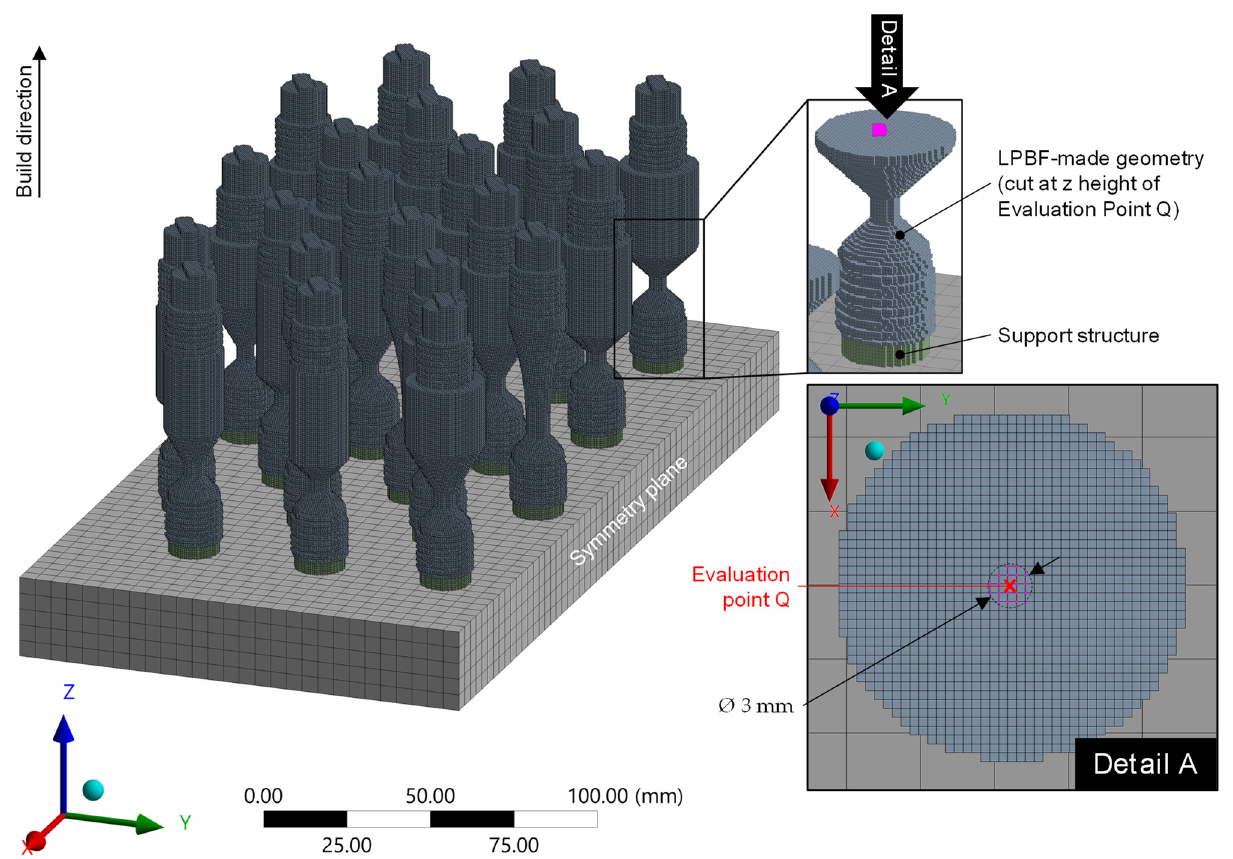
Figure 5. Sample arrangement in thermal simulation model of geometry variants Geo-a–Geo-u for tensile testing, Detail A showing evaluated node selection around evaluation point Q enclosed in respective tensile test sample diameter of 3 mm.